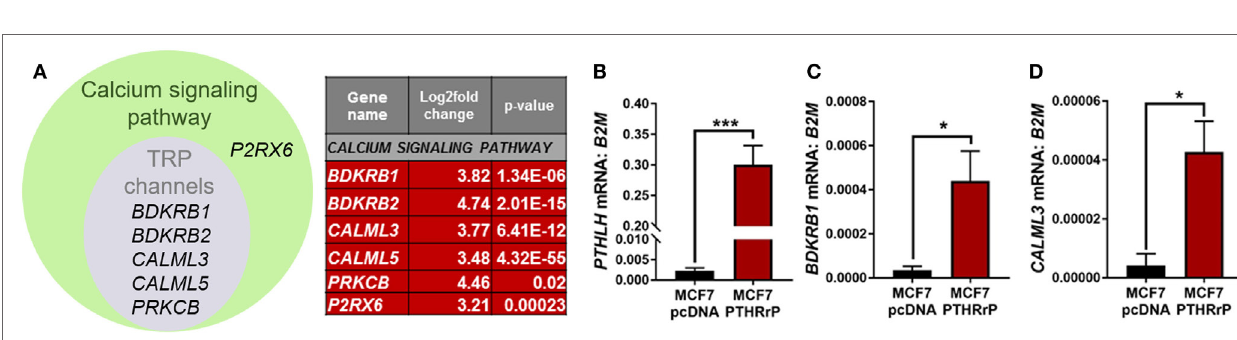
FigUre 5 | The calcium signaling pathway is significantly enriched downstream of parathyroid hormone-related protein (PTHrP) in MCF7 cells. (a) Venn diagram indicating the calcium signaling pathway and transient receptor potential (TRP) channel genes that were significantly upregulated in PTHrP-overexpressing cells (gray circle). There was also one significantly enriched gene that was unique to the calcium signaling pathway, P2RX6 (green circle). (B) PTHLH mRNA levels, shown as a control for PTHrP overexpression, in MCF7pcDNA control or MCF7 PTHrP-overexpressing cells (c,D) . qPCR for mRNA levels of calcium signaling pathway genes in MCF7pcDNA or MCF7 PTHrP-overexpressing cells. Graphs = mean + SE. n = 3 replicates from independent experiments. * p < 0.05, *** p < 0.001 by Unpaired Student’s T